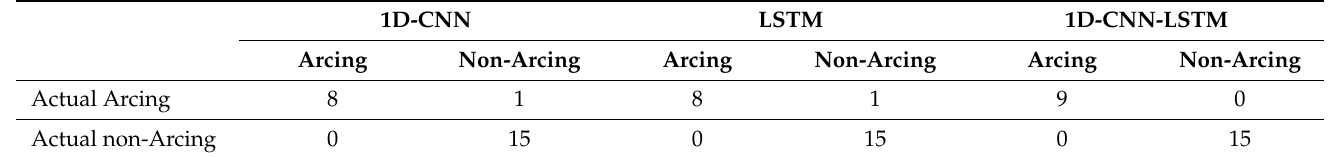
Table 10. Testing Phase Output Matrix: Frequency Domain Arcing Fault